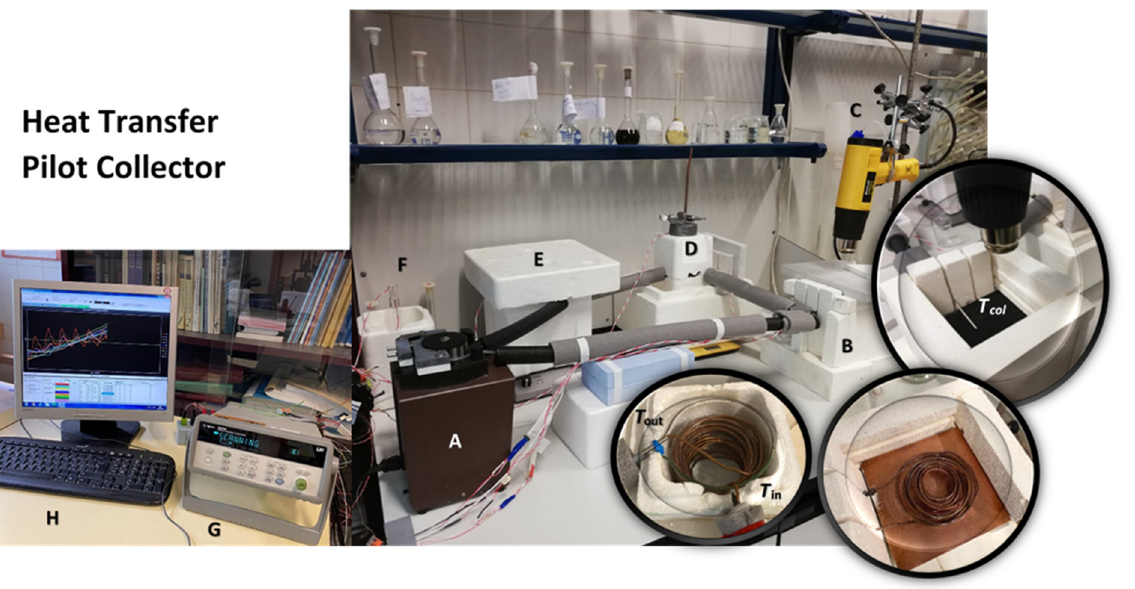
Figure 4. The heat transfer pilot collector. A—Peristaltic pump; B—Absorbing panel, with selective absorptive paint. T col is the surface thermometer of the panel; the copper serpentine is for fluid circulation; C—Hot air gun; D—Heat storage (water), showing copper serpentine. T in and T out are the measuring thermometers; E—Fluid reservoir; F—Room temperature measurement; G—Multiplexer; and H—Monitor with heating curves.